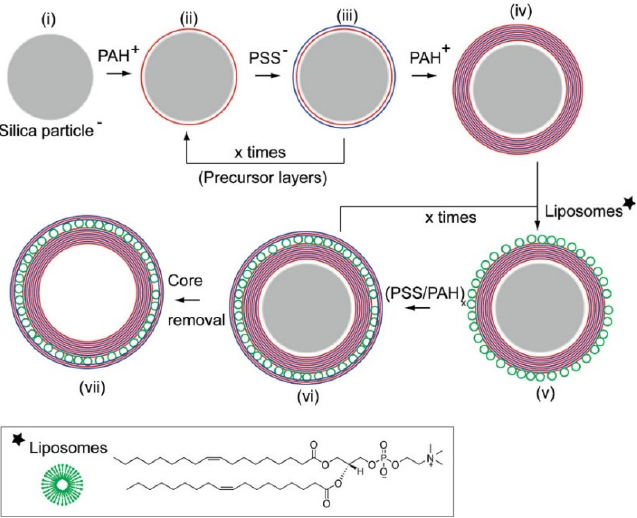
Figure 9. Idealized representation of the fabrication procedure used for obtaining multicapsules.